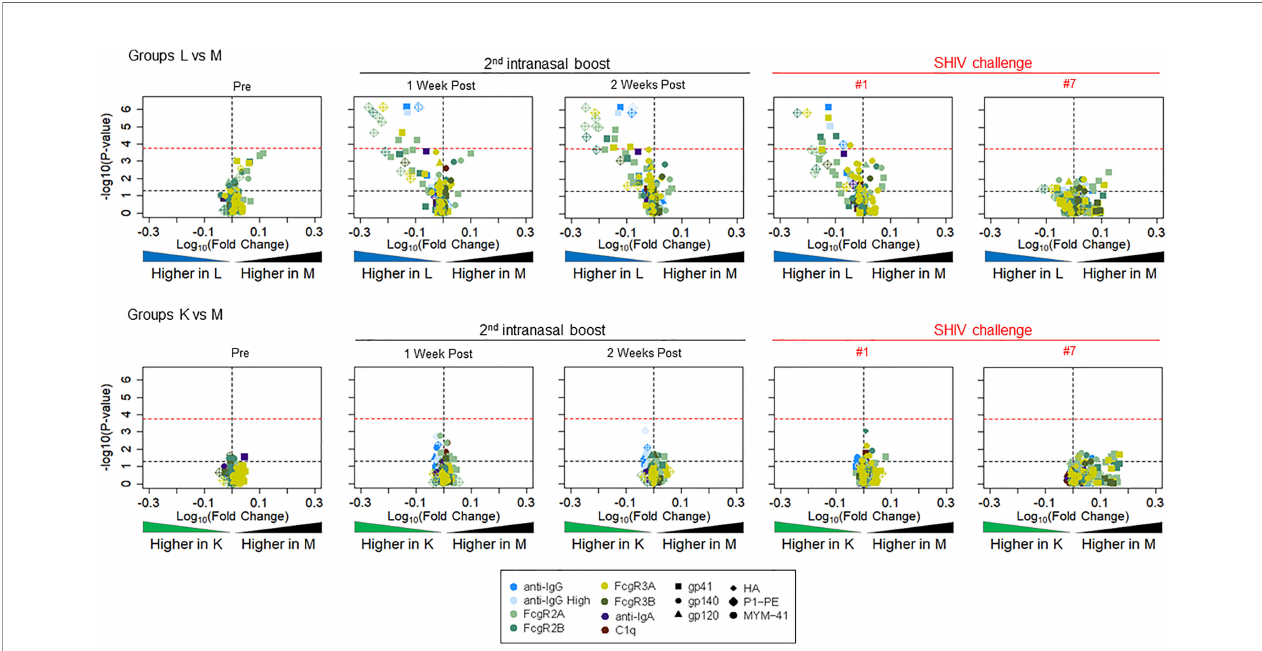
FIGURE 10 | Volcano plots depicting fold change and signi fi cance of differences in Fc Array antibody features between immunization Groups L (top, given virosome- P1 + virosome-rgp41) and K (bottom given single-agent virosome-P1) and the control arm (Group M given placebo virosomes). Symbol shapes indicate Fc speci fi city and color indicates Fc characteristic. Horizontal lines indicate statistical signi fi cance by Mann-Whitney U test, with p = 0.05 indicted by the black dotted line, and a Bonferroni-adjusted signi fi cance threshold indicated in the red dotted line. Group comparisons of antibody pro fi les at time points including pre-immunization (pre), one or two weeks after the 2 nd intranasal boost, the day of the 1 st SHIV challenge, and the day of the 7 th SHIV challenge are reported; please see Figure 3